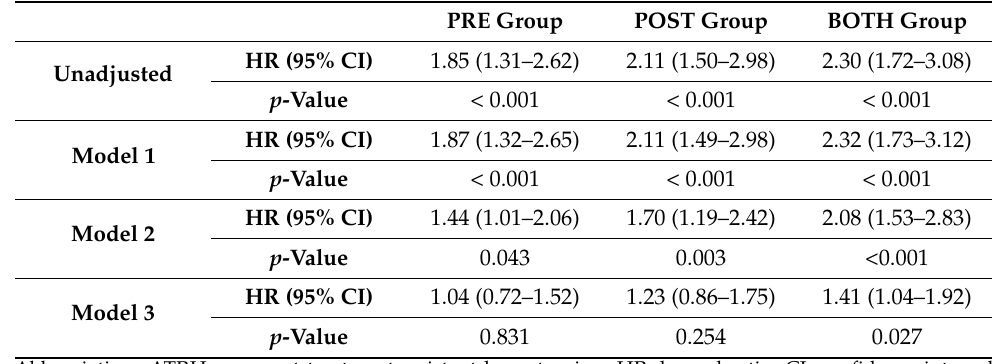
Table 3. Hazard ratios for renal outcome according to the ATRH